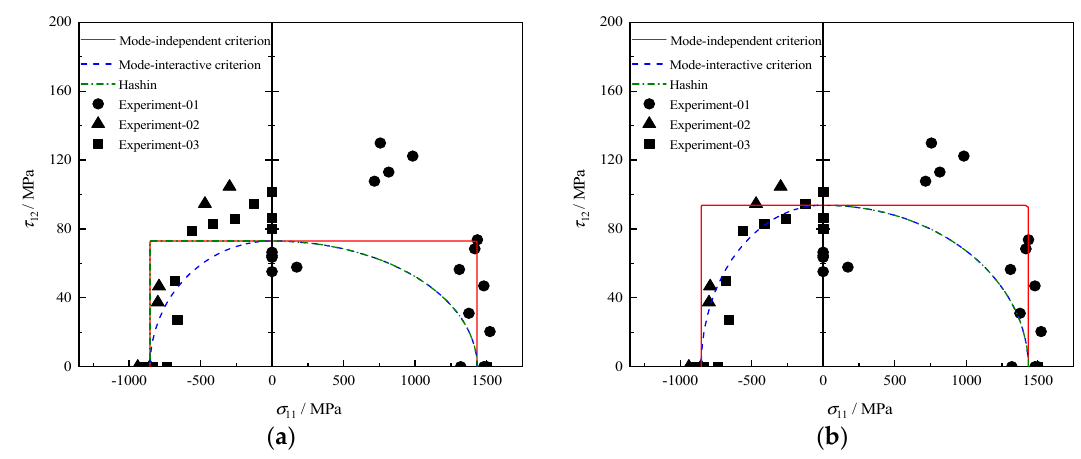
- σ τ for T300/BSL914C with ( a ) 11 12